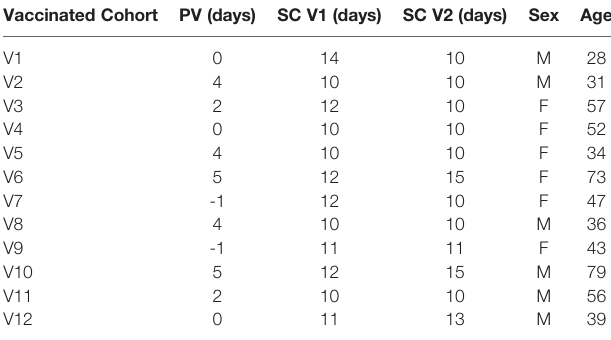
TABLE 2 | Demographic data of vaccinated patients.